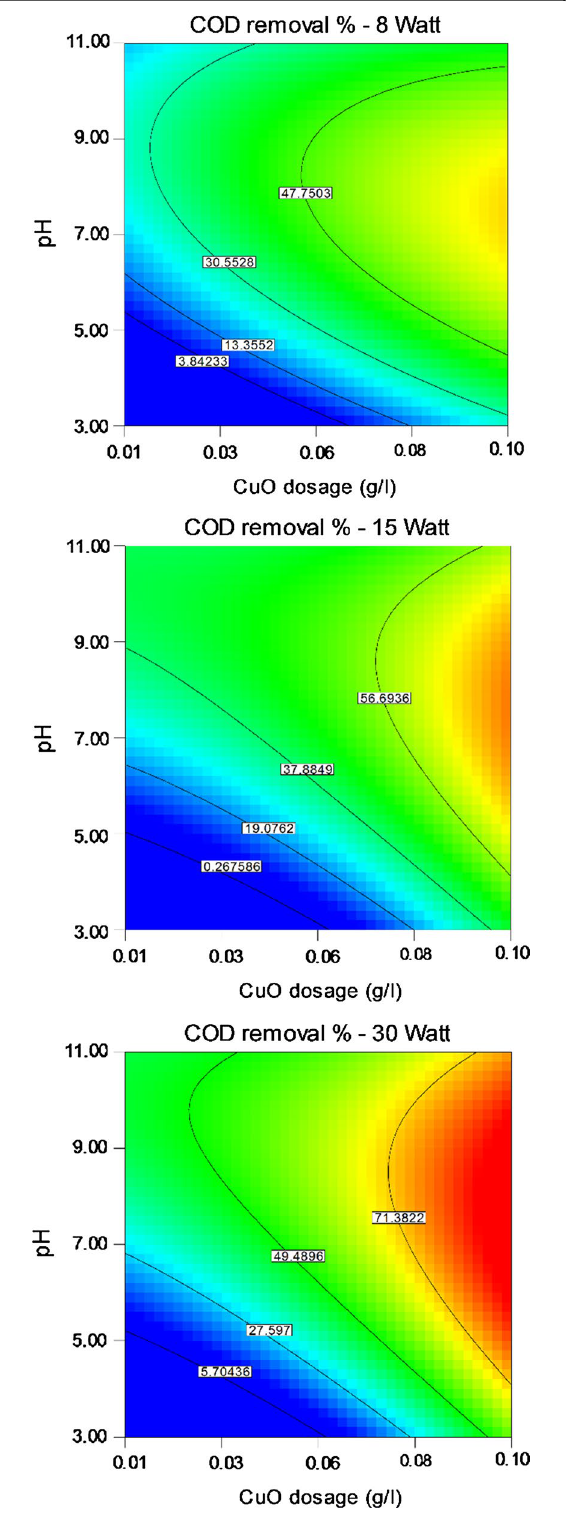
Fig. 6 Effect of CuO dosage and solution pH on COD removal